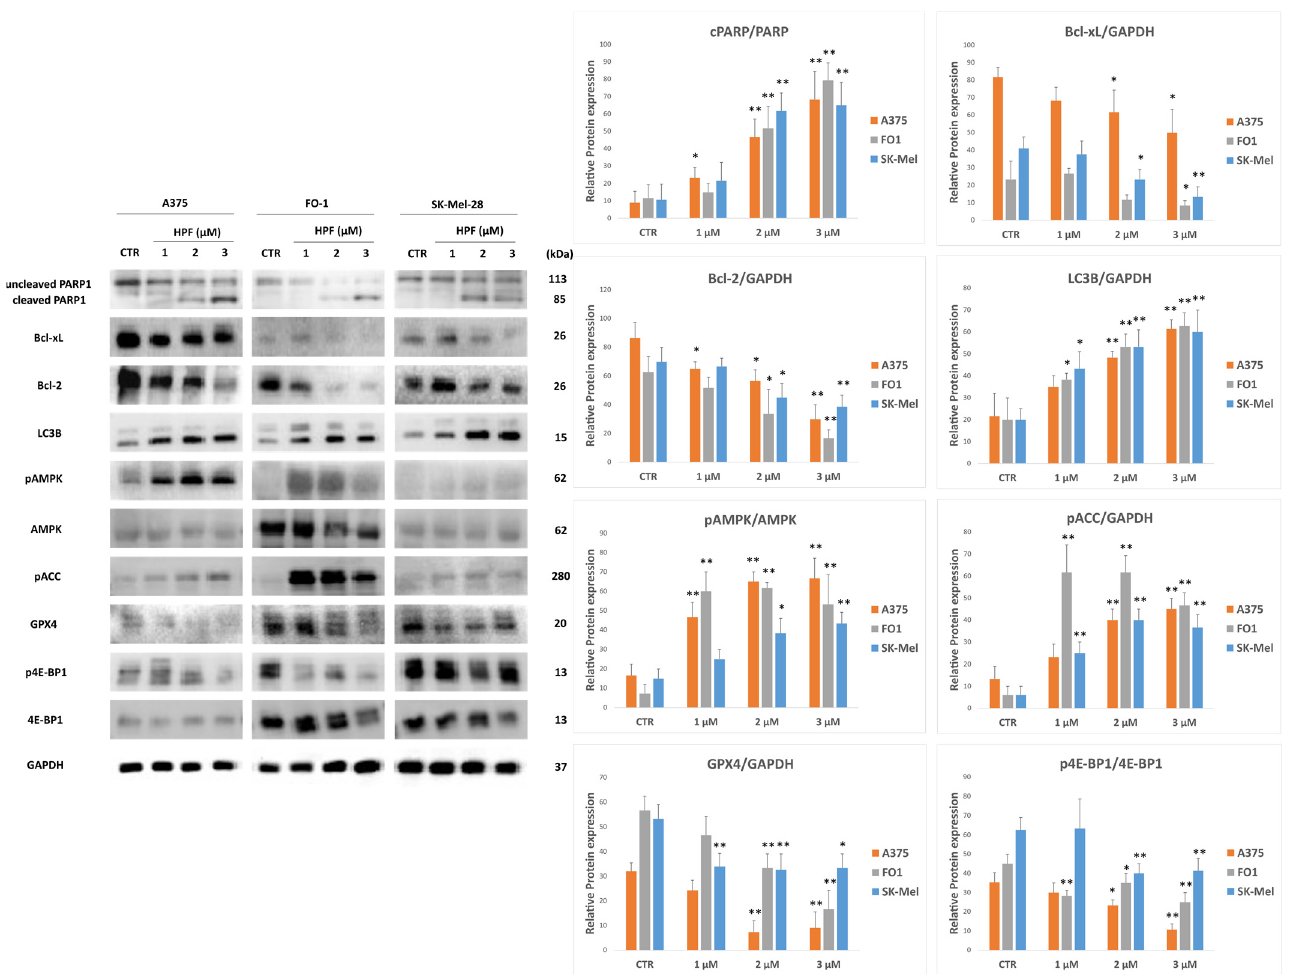
Figure 4. Hyperforin affects the expression of several proteins involved in apoptosis, autophagy and ferroptosis induction. A375, FO-1 and SK-Mel-28 melanoma cells were treated with increasing concentrations of HPF for 24 h. In the left panel, representative immunoblots show the expression level of cleaved and uncleaved PARP1, Bcl-extra-large (Bcl-xL), Bcl2, microtubule-associated proteins 1A/1B light chain 3B (LC3B), the phosphorylated form of AMP-activated kinase (pAMPK), total AMPK, the phosphorylated form of acetylCoA carboxylase (pACC), glutathione peroxidase 4 (GPX4), the phosphorylation level of eIF4E-binding protein 1 (4E-BP1), total 4E-BP1 and glyceraldeide-3- phosphate dehydrogenase (GAPDH). On the right, histograms represent the mean values ± S.D. of protein expression level measured by densitometry deriving from three or more independent experiments and normalized with GAPDH expression, unless otherwise stated. All comparisons were performed vs. each control sample after data normalization; * p < 0.05; ** p <